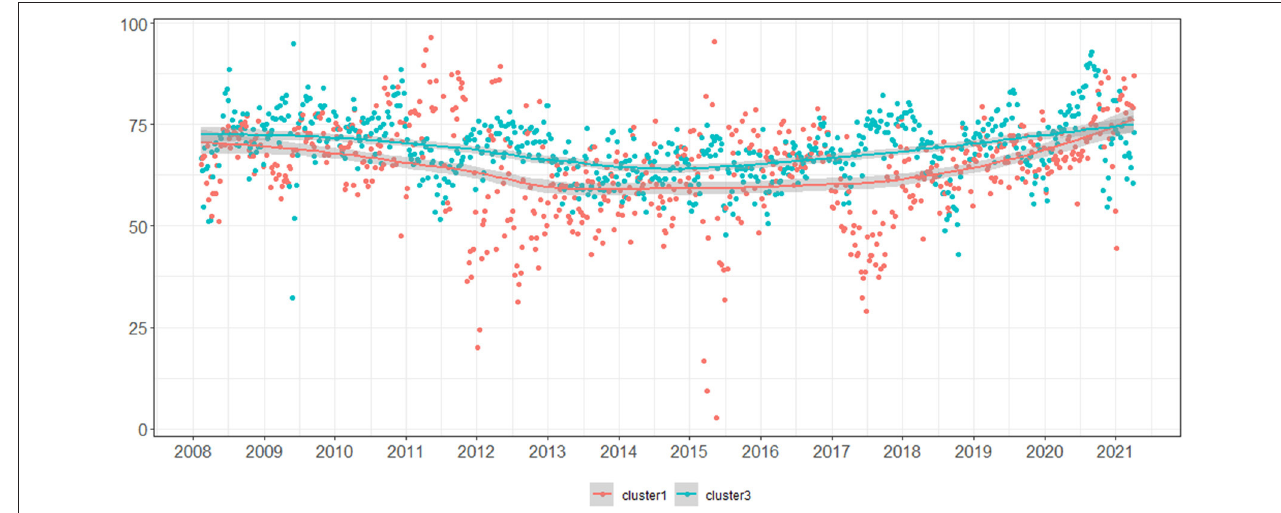
FIGURE 2 | Mean weekly results obtained by all participants grouped in Cluster 1 (red) and Cluster 3